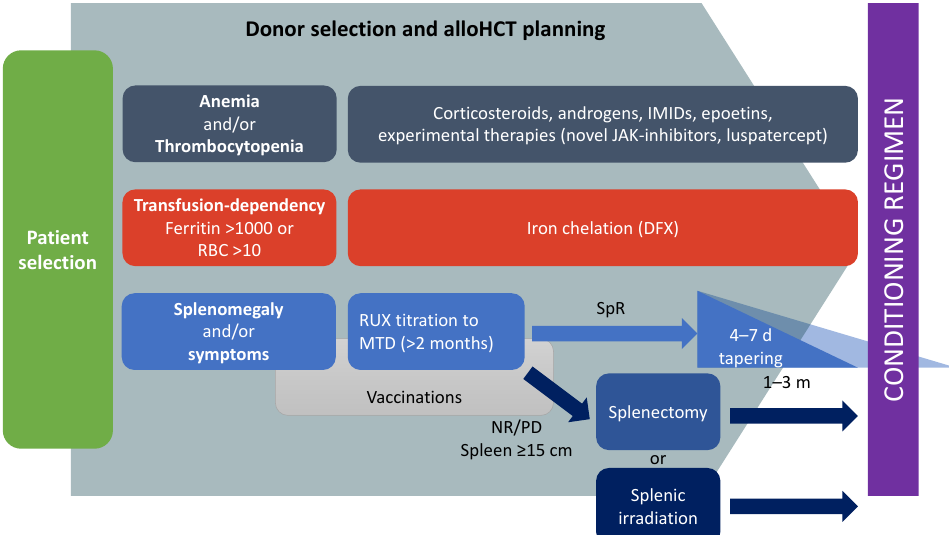
Figure 1. Proposed pre-transplant management of MF candidates to allogeneic stem cells